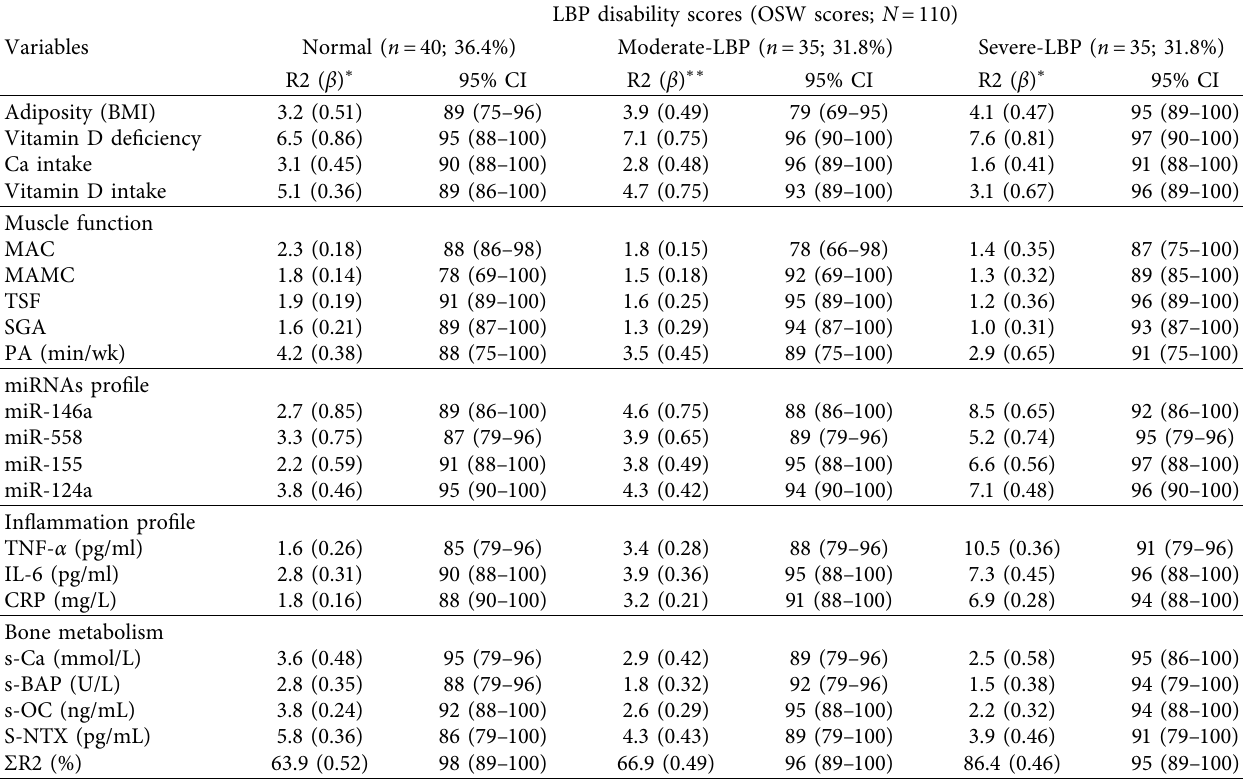
Table 3: Stepwise multiple regression analysis for LBP predicted by adiposity, muscle function, PA score, malnutrition scores, markers of bone metabolism, inflammatory markers, vitamin D status, and miRNAs profile as the significant correlates in subjects with LBP ( n � 110).